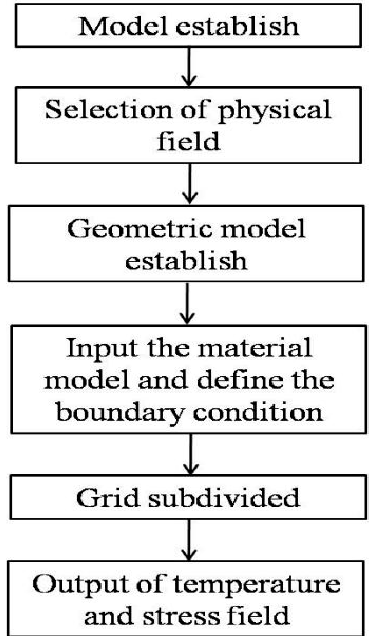
Figure 5. Computable flow graph of simulation process.